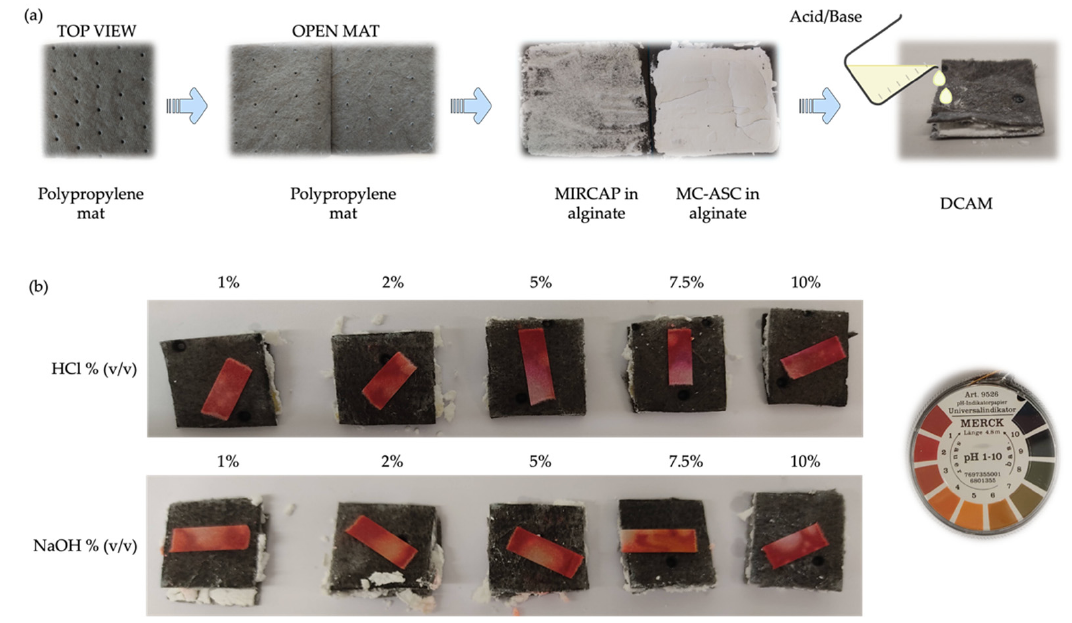
Figure 3. ( a ) Method for DCAM preparation; ( b ) pH strips placed on the bottom of the DCAM, exposed to the leaked acid or alkali solution at different concentrations (1 to 10% (v/v)).